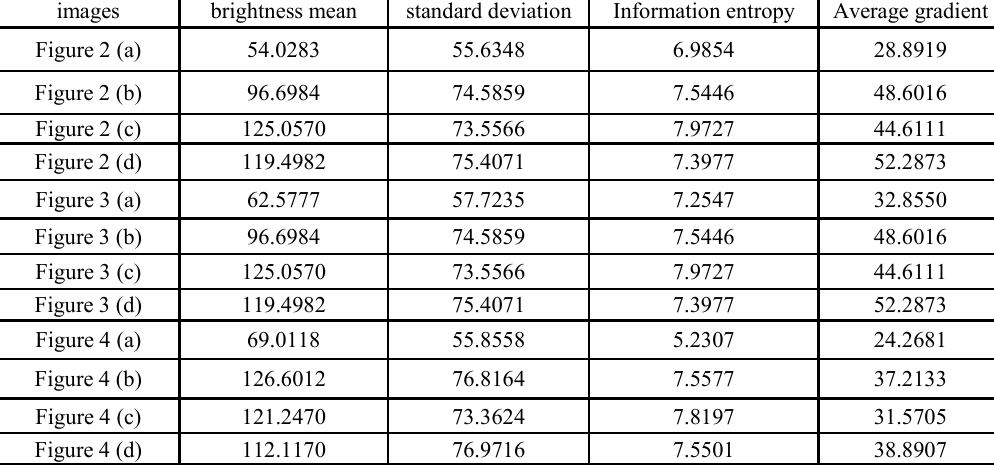
Table 2 Comparison of quantitative evaluation indicators for